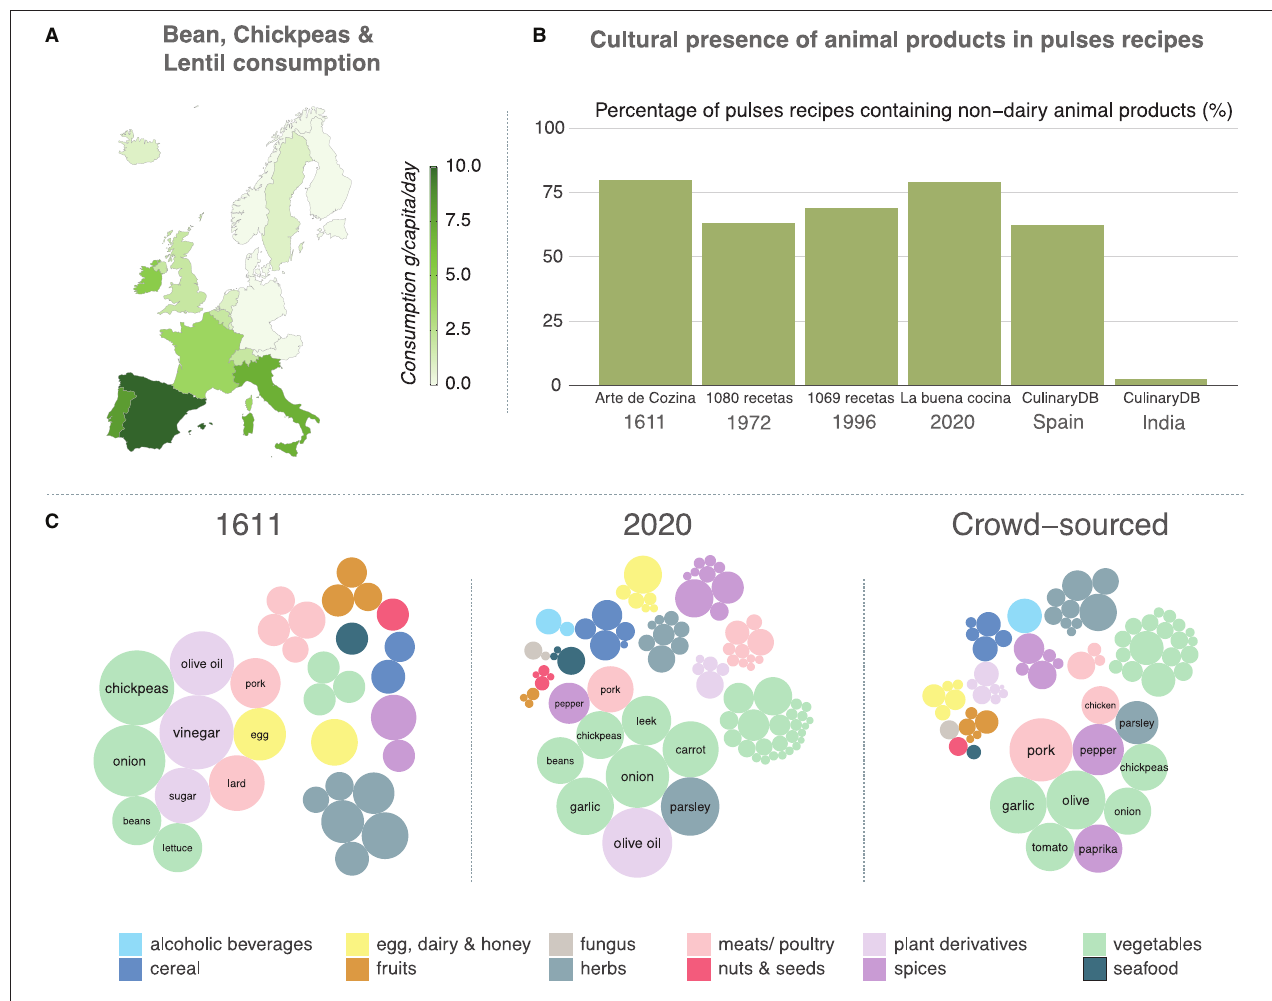
FIGURE 4 | A complex systems view of food consumption. (A) shows a comparison of the intake of legumes in Southern, Western and Northern Europe, which reveals the role of sociocultural factors. Looking at the ingredients that are commonly paired with these legumes in Spanish cuisine, one finds that this consumption is heavily related to the consumption of non-dairy animal products, although this is not true for the Indian cuisine sample (B) . In (C) , each circle represents a single ingredient used in at least one recipe containing beans, chickpeas or lentils. The size of the circle is proportional to the number of recipes containing the ingredient and the color the group they belong to. In all cases only the top 10 ingredients are